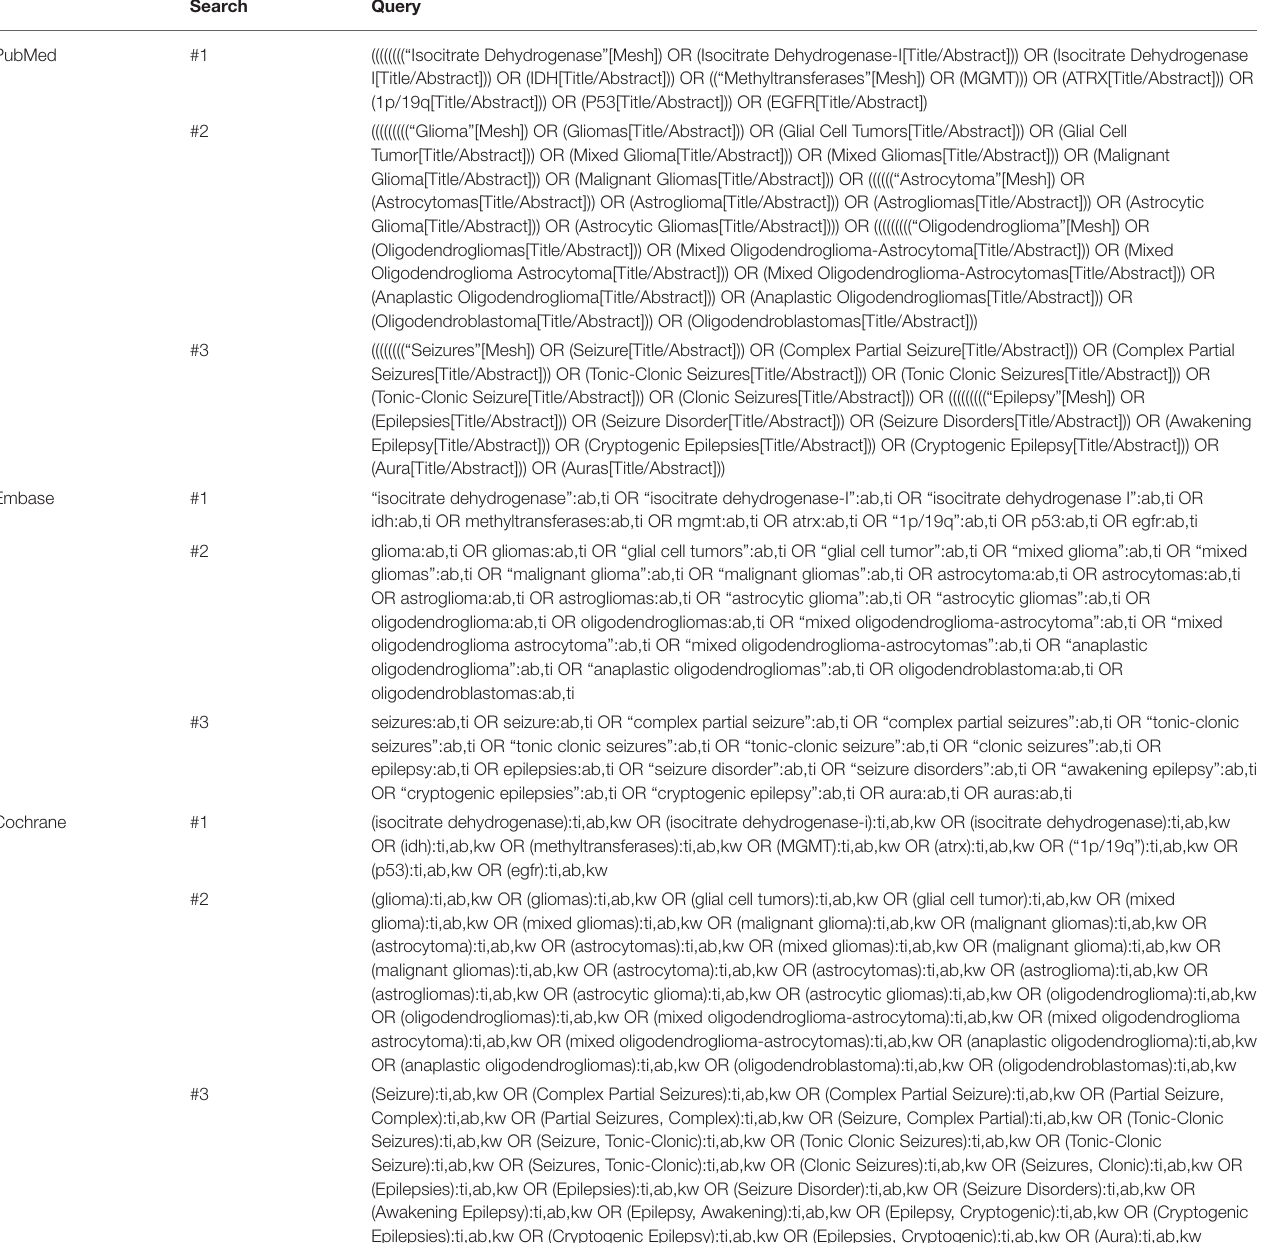
TABLE 1 | Retrieval